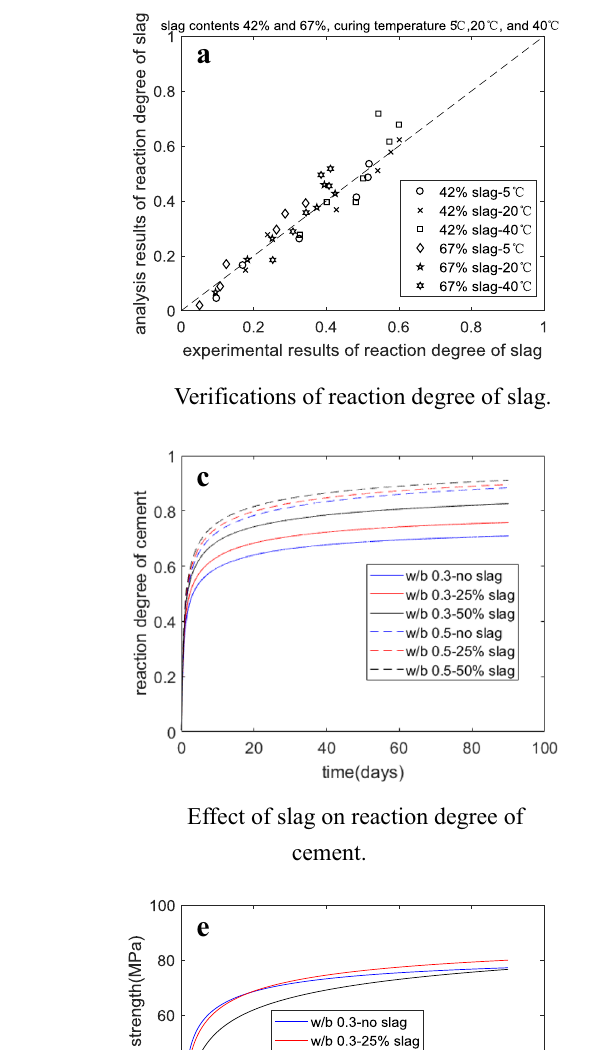
hydroxide, [ CSH ] is the molar content of CSH produced, ε is the concrete porosity, and RH is the environmen- tal relative humidity. [ CH ] + 3 [ CSH ] in the denomina- tor of Eq. (16) is the content of carbonatable material. For climate change conditions, CO 2 concentration and